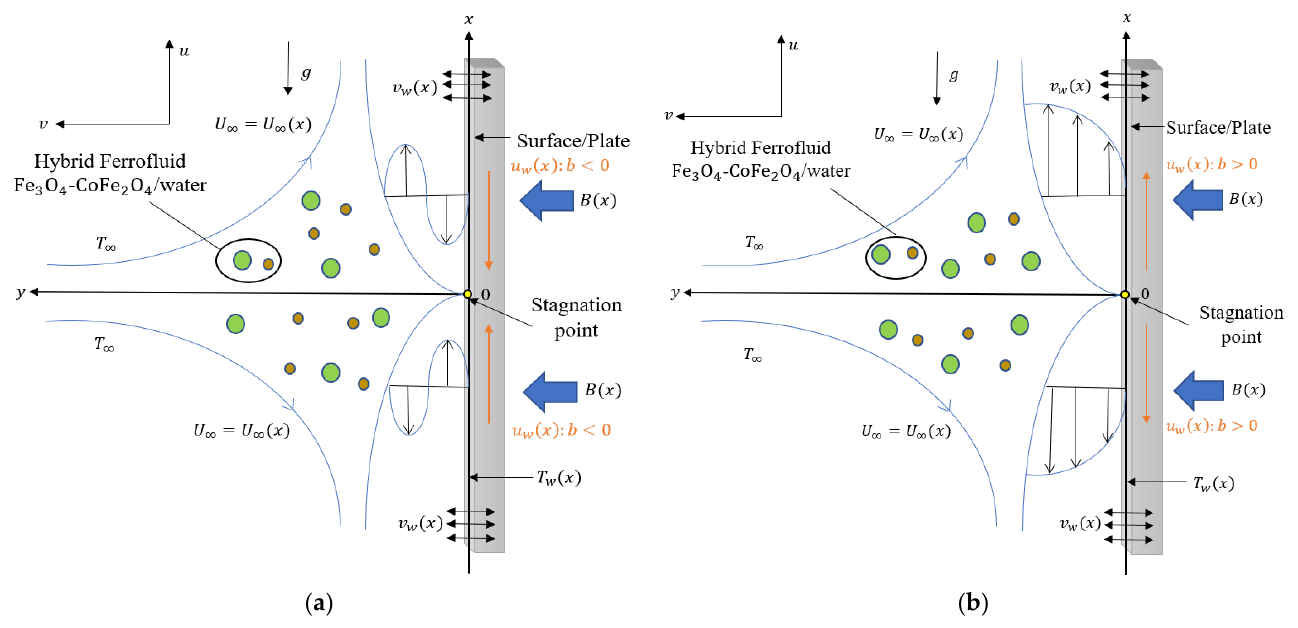
Figure 1. Physical Model. ( a ) Shrinking b < 0. ( b ) Stretching b > 0. As for the nanoparticle volume fraction in hybrid ferrofluids (Fe 3 O 4 -CoFe 2 O 4 /water), Fe 3 O 4 is the first ferroparticle volume fraction parameter, φ 1 , while CoFe 2 O 4 is the second ferroparticle volume fraction parameter, φ 2 . The shape formed for the hybrid ferrofluids is in a stable spherical shape of nanoparticle and uniform size, while the agglomeration effects are disregarded. In this instance, Tiwari and Das ’ [25] mathematical nanofluid model is used. It is worth noting that this nanofluid model uses a single-phase approach and assumes that all of the particles are homogeneous in size and shape. Additionally, it ignores interactions between the particles and the fluid they are in contact with [68,69]. Since the base fluid can be thought of as acting as a single fluid when it is readily fluidized, this presumption is realistic and supports the use of the single-phase model in this investigation. The boundary layer is assumed to be laminar, as the fluid flow velocity changes evenly as the fluid flow moves away from the wall surface. Of note, the assumption made on the boundary layer approximation is due to the boundary layer’s edge responding to the external flow in the same way that an object’s actual surface would. Therefore, the boundary layer provides every object with an “effective” shape that is typically slightly distinct from its actual shape. Under the assumption of Boussinesq and boundary layer approximations mentioned above, the governing equations can be written as [22,50].